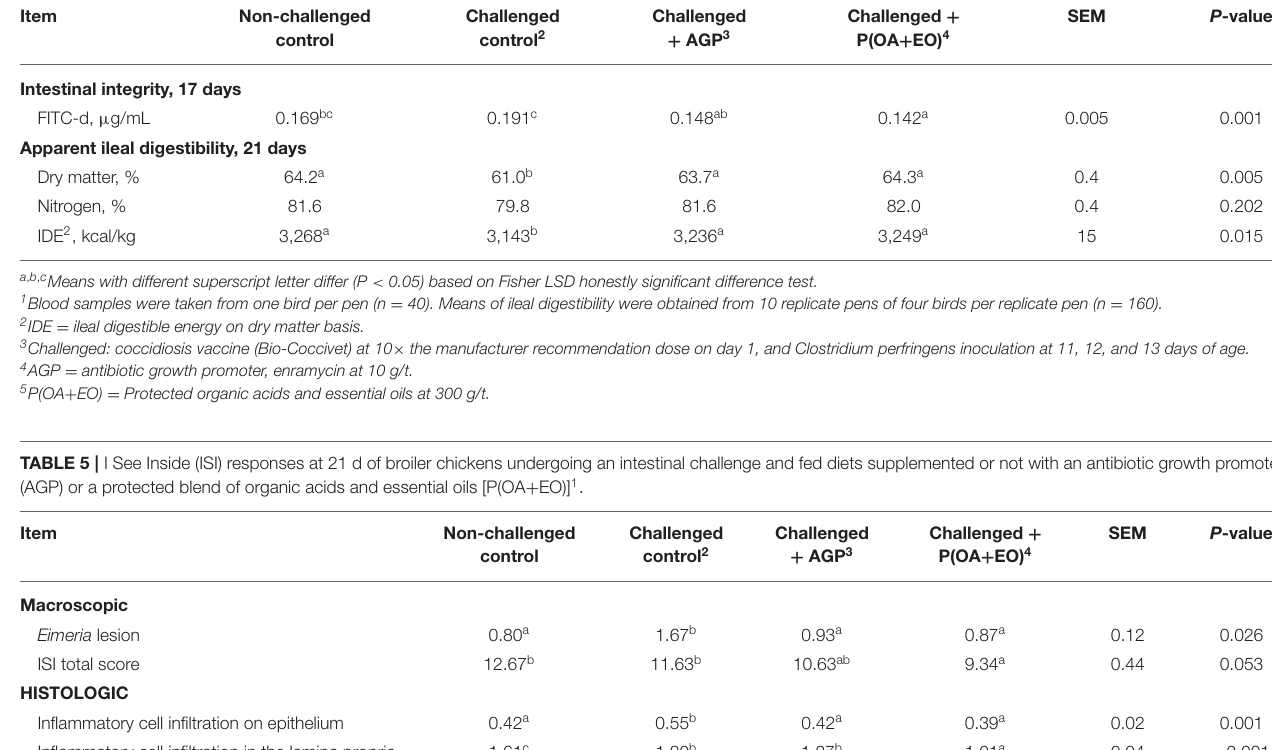
TABLE 4 | Serum FITC-d and apparent ileal digestibility of broiler chickens undergoing an intestinal challenge and fed diets supplemented or not with an antibiotic growth promoter (AGP) or a protected blend of organic acids and essential oils [P(OA + EO)] 1 . Item